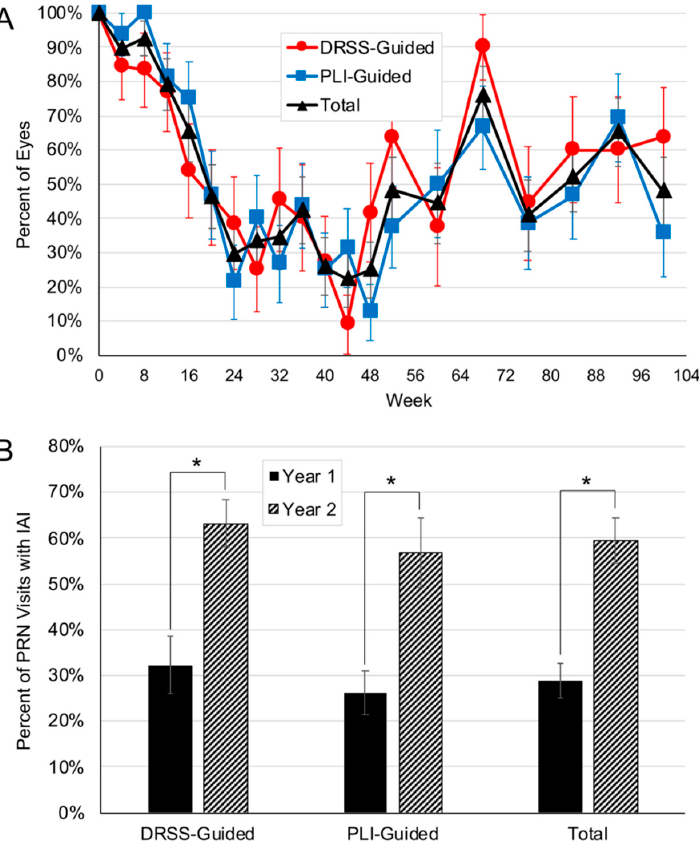
Figure 1. Intravitreal aflibercept injections (IAI) administered through week 104. ( A ) Percent of eyes treated at each visit in the diabetic retinopathy severity scale (DRSS)-guided and the panretinal leakage index (PLI)-guided arms. ( B ) Percent of pro re nata (PRN) visits with IAI administration in year 1 and year 2. In the DRSS-guided arm, 32.2% and 63.2% of PRN visits resulted in IAI administration in year 1 and year 2, respectively. In the PRN-guided arm, 26.1% and 56.8% of PRN visits resulted in IAI administration in year 1 and year 2, respectively. Asterisks indicate statistically significant differences between groups.